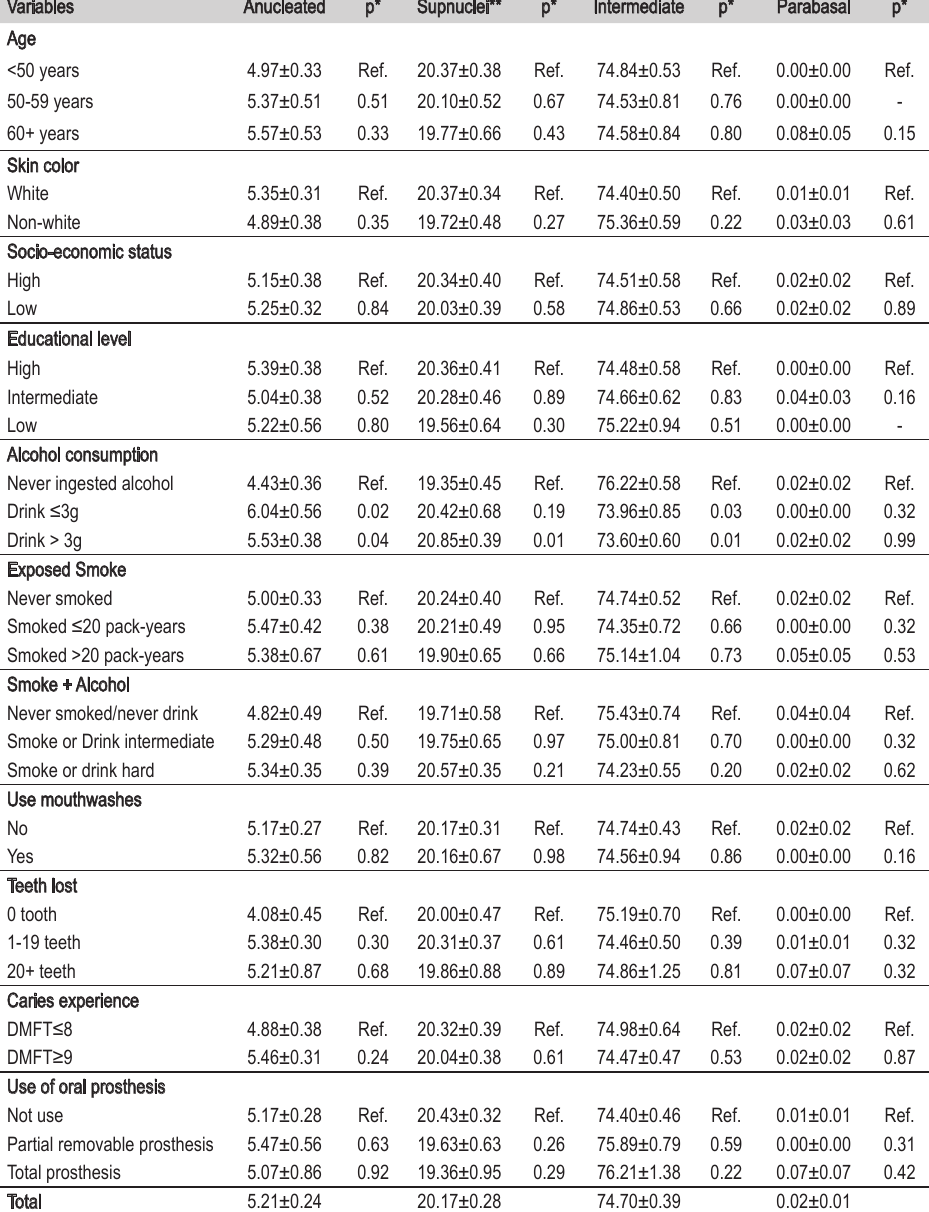
Table 2 - Mean distribution (standard error) the percentage of the type of cells on the border of tongue according to independent